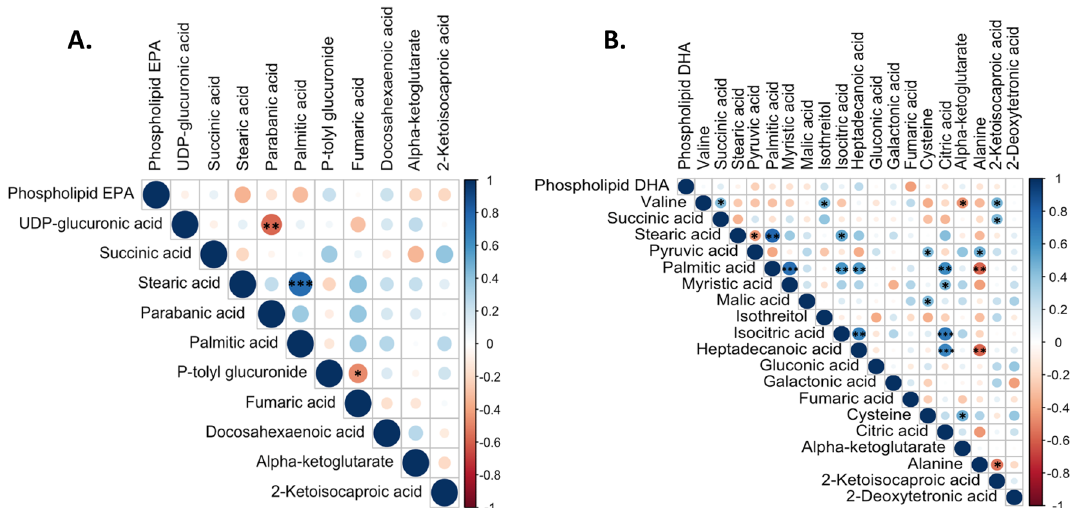
Figure 3. Correlation among metabolite changes after EPA and DHA supplementation. Metabolites shown to have significant changes after EPA and DHA supplementation were included for the Pearson’s correlation analysis. Positive and negative correlation are presented in blue and red, respectively. ( a ) Changes in metabolites and phospholipid EPA concentrations after EPA supplementation; ( b ) Changes in metabolites and phospholipid DHA concentrations after DHA supplementation. * P < 0.05, ** P < 0.01, *** P <